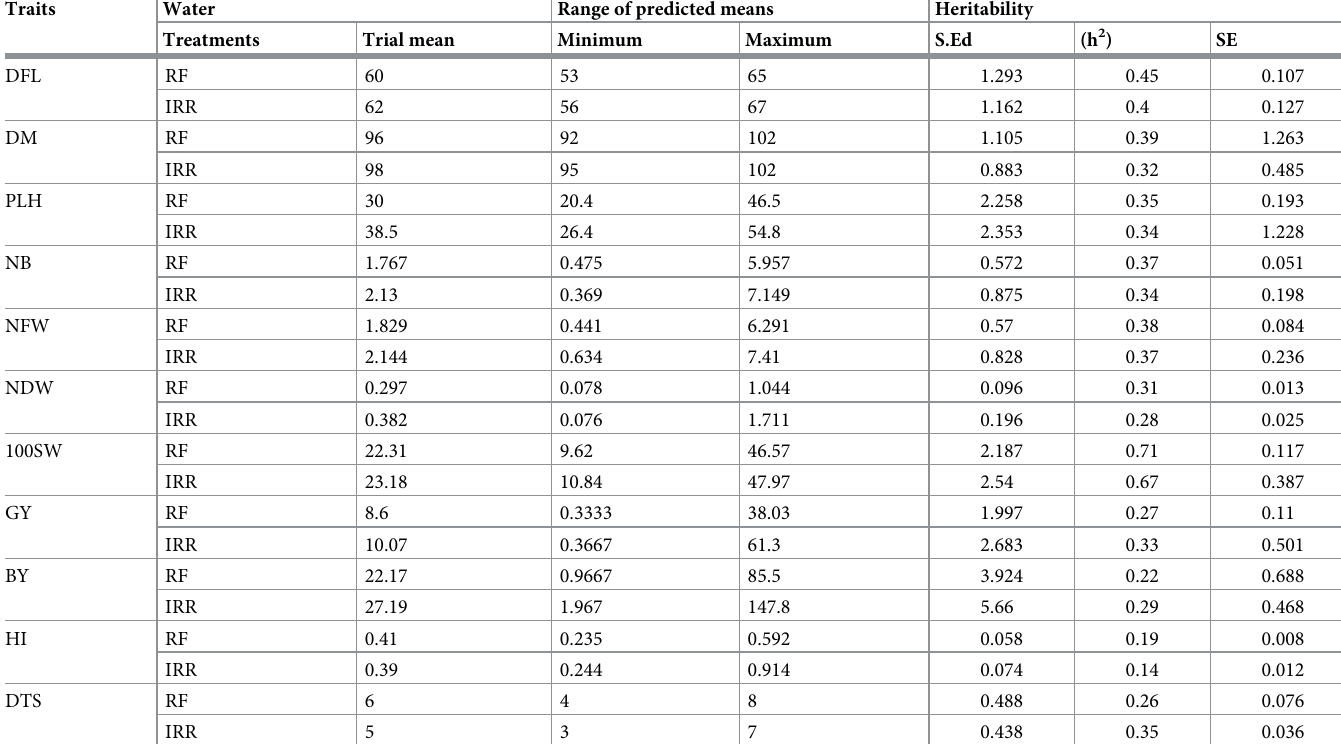
Table 2. Trial means, for morphological traits and yield components of 204 genotype in the field experiment under two water treatments at two locations during 2016 and 2017 seasons. Traits